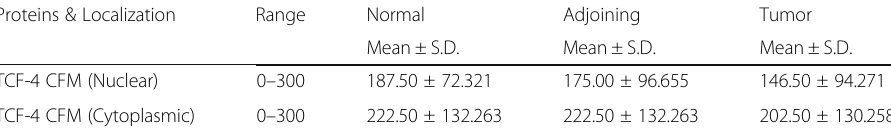
Table 4 Confocal microscopic scores for TCF-4 proteins in tumor, adjoining and normal mucosa of